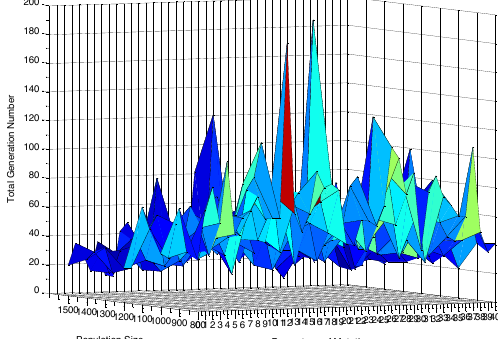
Figure 5.3.1 Generation Number when Total Percentage is 40%